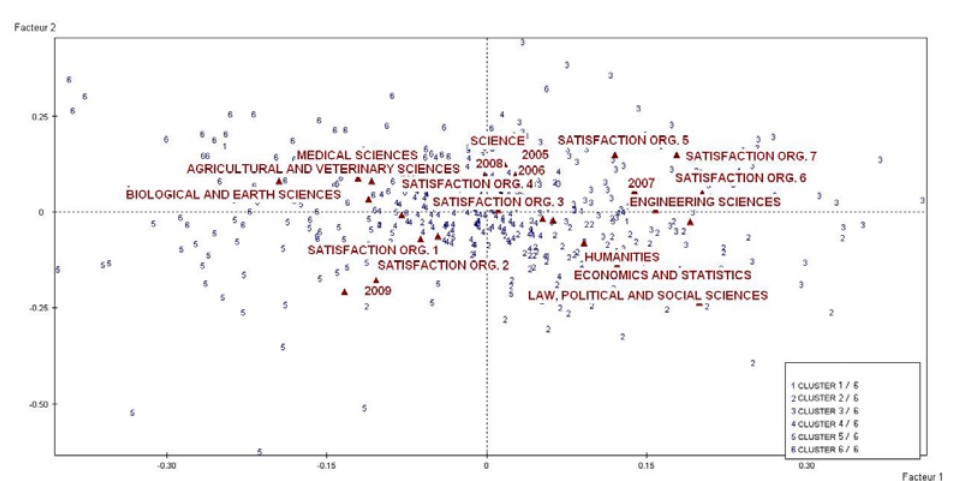
Figure 2 – Factor plan of keywords distribution compared to categorical